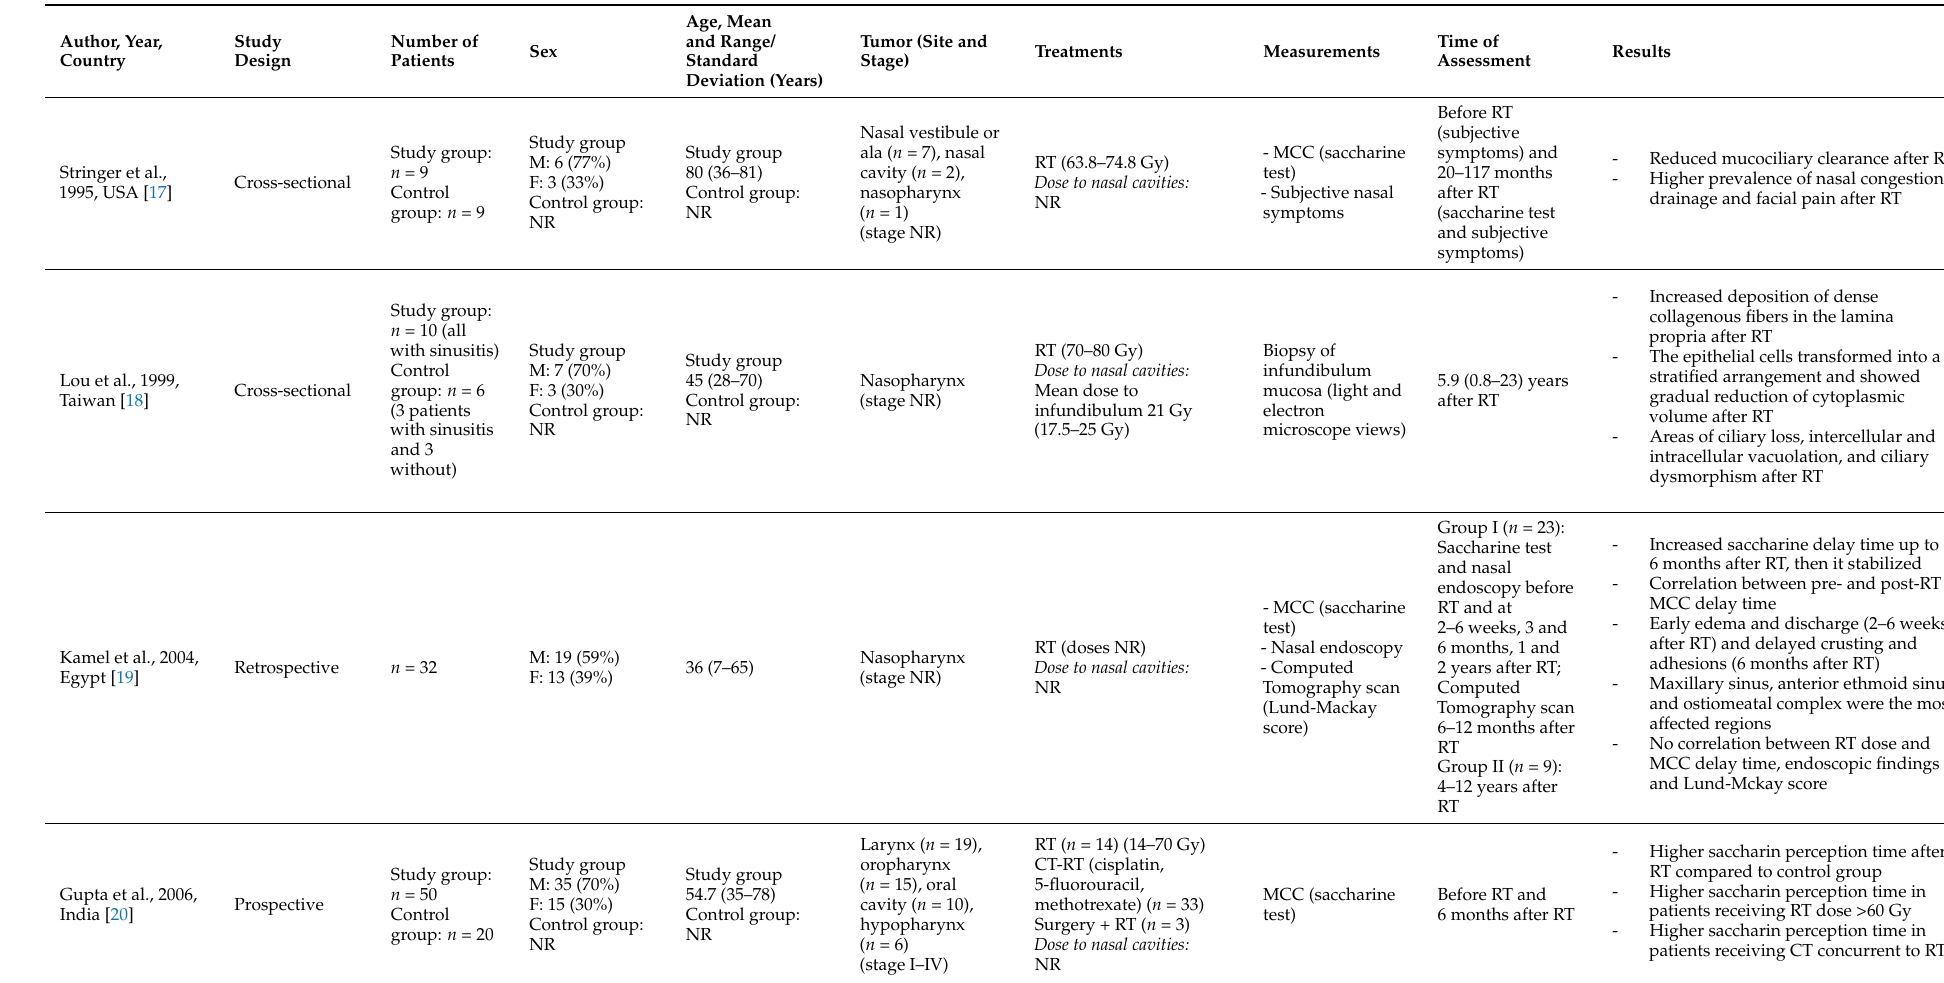
Table 1. Sinonasal mucosa disorders: studies included in the